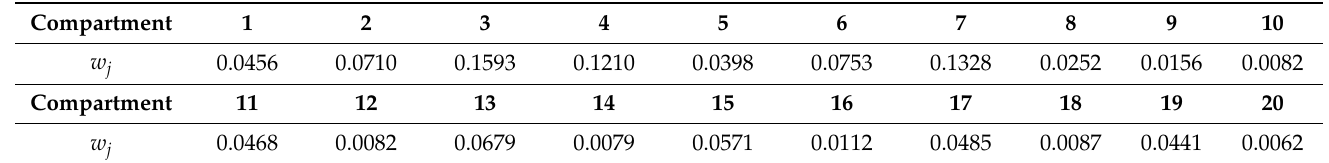
Table 7. Average contribution weight of each compartment for metabolism of COD and TP in 2019 in Fuzhou.